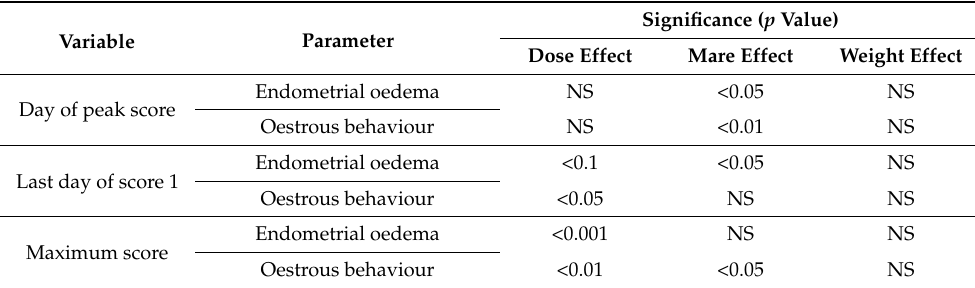
Table 1. Effects of dose, mare and weight on endometrial oedema and oestrous behaviour scores in anoestrous mares administered a single treatment of oestradiol benzoate.